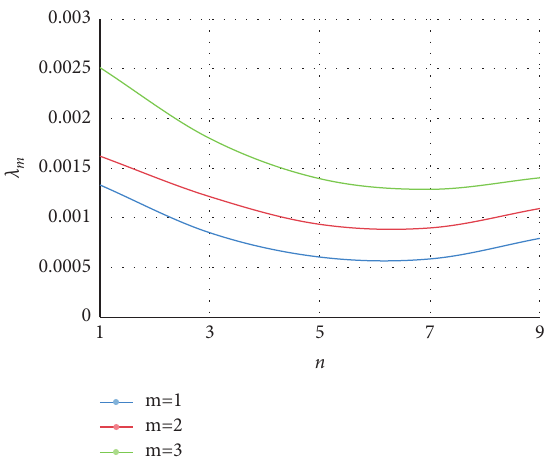
Figure 9: Relation between frequency and circumferential node number of three-layered shells 0 0 /90 0 /0 0 ( GE / KE / GE ) ; L � 0 . 5.